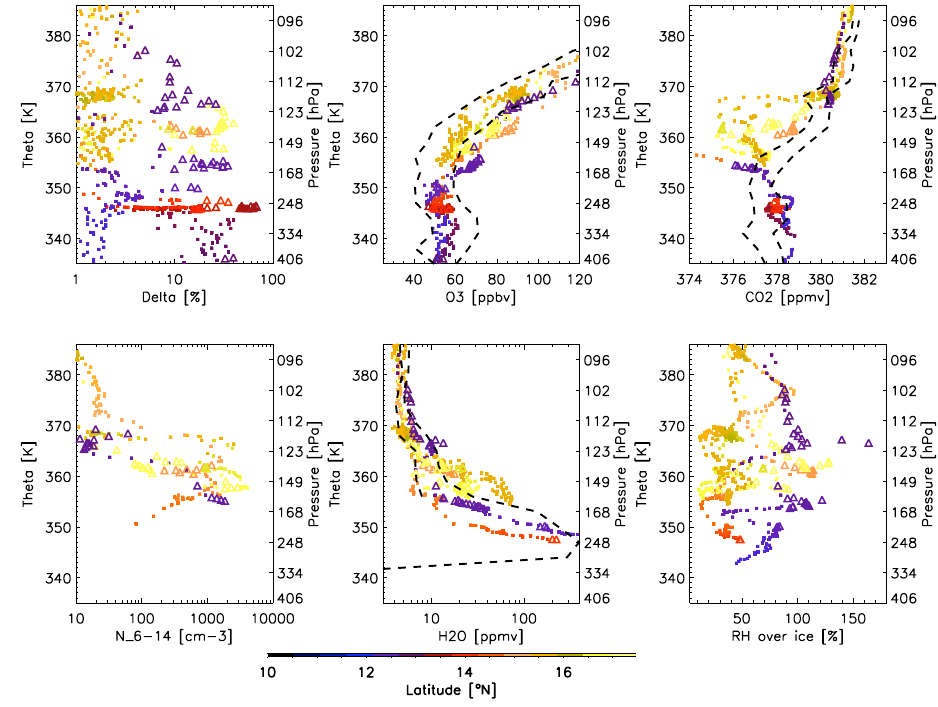
Fig. 4. As Fig. 2 but for 11 August